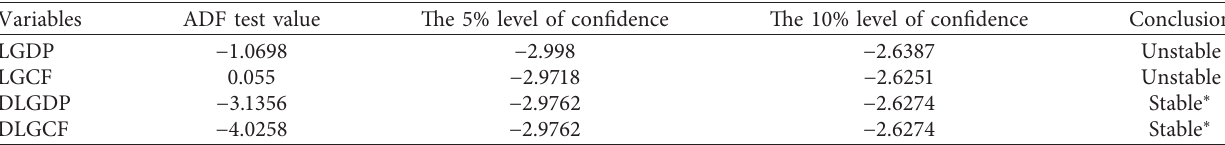
Figure 4: A graphical representation showing a comparison between LGDP and LGCF data from 1990 to 2018. The X -axis shows the number of years, while the Y -axis shows values in millions of Pakistani rupees. Table 2: Result of the ADF unit root